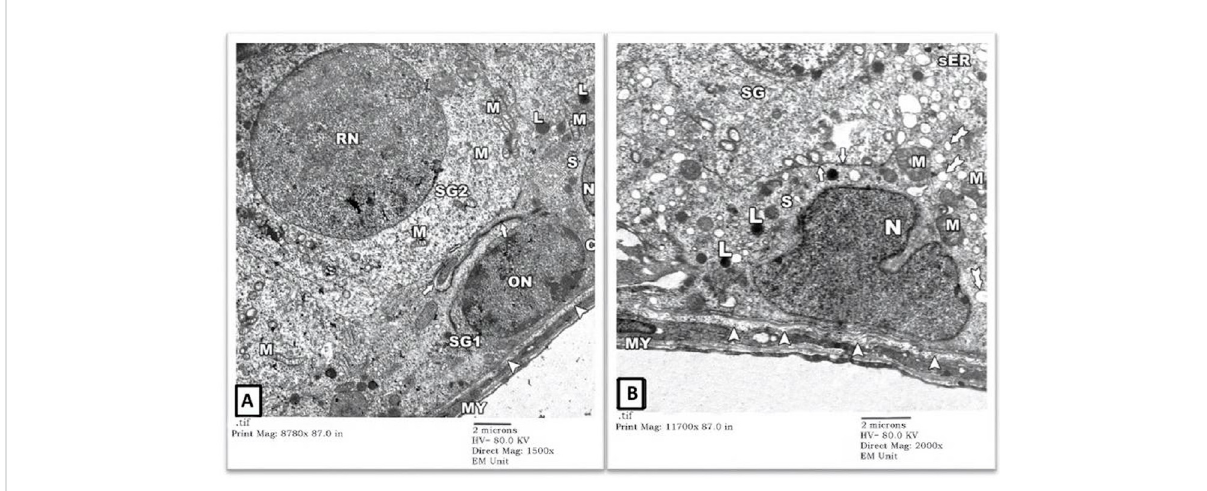
FIGURE 1 An electron micrograph of a part of seminiferous tubule from testis of a rat in control group showing: (A) a spermatogonium (SG1) with an oval nucleus(ON) and apart ofSertolicell(S)resting onthebasementmembrane(arrowheads) surrounded byathinconnective tissue sheathcontaining myoid cells (MY). Sertoli cell exhibits a part of its indented nucleus (N), its irregular cell border (thick arrow), mitochondria (M), numerous vesicles of sER(insidetherectangle),andlysosomes(L).Anotherspermatogonium(SG2)showsaroundnucleus(RN)andmitochondria(M).(Uranylacetate and lead citrate X 1500, Print Mag. X 8780). (B) Sertoli cell (S) resting on the basement membrane shows an indented nucleus (N), mitochondria (M), lysosomes (L), and lipid droplets (tailed arrows). Its irregular cell membrane (thick arrows) separates it from adjacent spermatogonium (SG). (Uranyl acetate and lead citrate X 2000, Print Mag. X